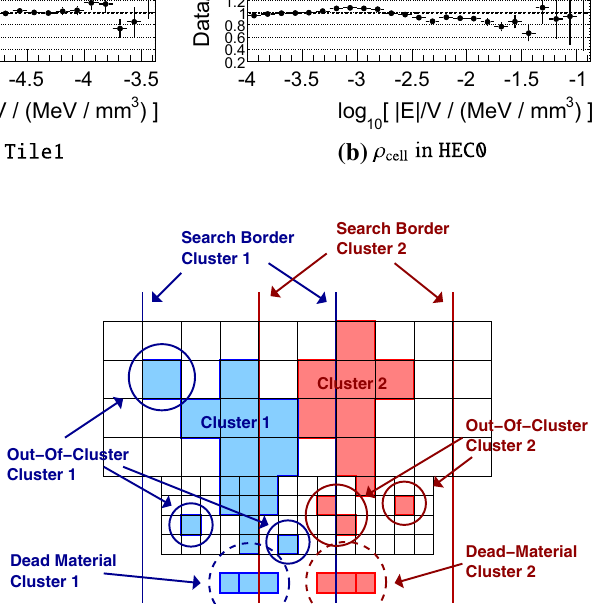
Fig. 14 Distributions of the cell energy density ρ cell in the central a and end-cap b hadronic calorimeters in ATLAS, as observed inside anti- k t jets with R = 0 . 6 calibrated with the GCW+JES scheme described in Ref. [38], in 2010 data and MC simulations (no pile-up). The data/MC ratio of the spectra is shown below the corresponding distributions. The figure uses plots from Ref. [38]